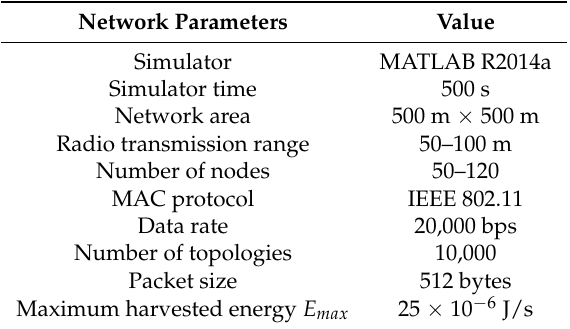
Table 1. Network